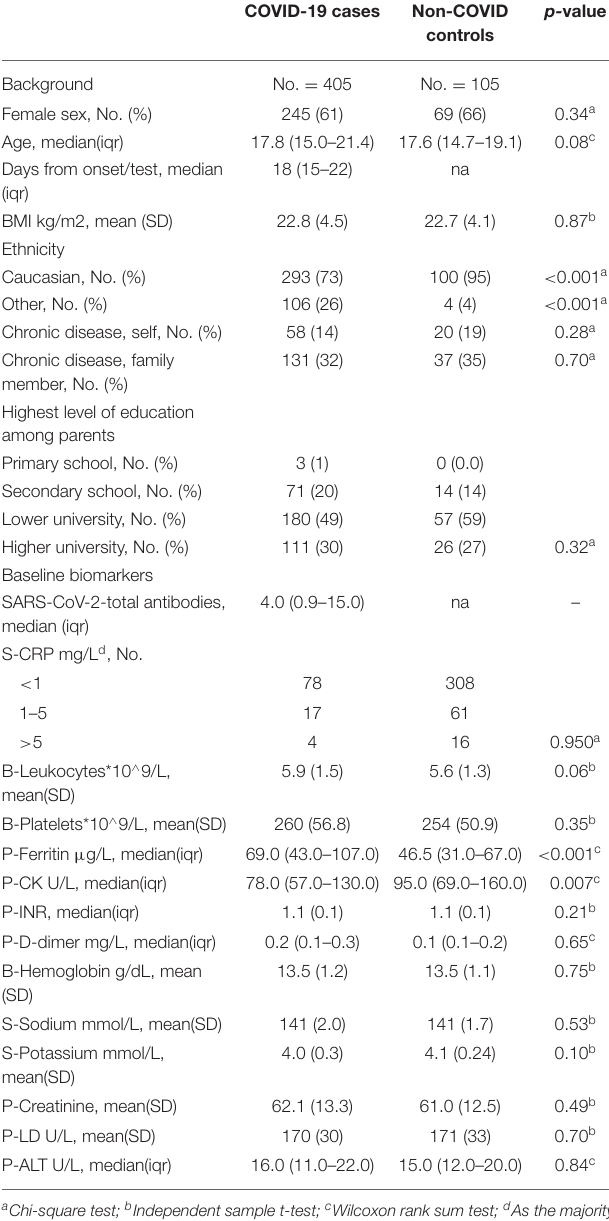
TABLE 1 | Baseline characteristics of included children and adolescents by SARS-CoV-2